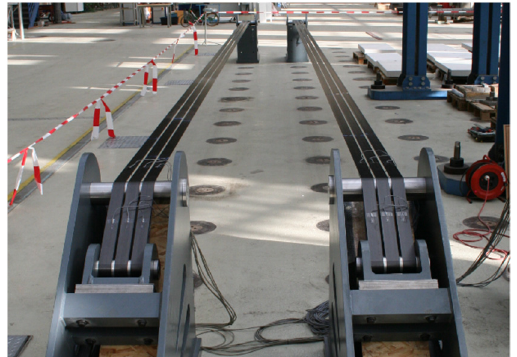
Figure 2. Stress-ribbon footbridge [15]. Reprinted with permission from ref. [15]. Copyright 2007 Ernst & Sohn Verlag für Architektur und technische Wissenschaften GmbH & Co. KG, Berlin.